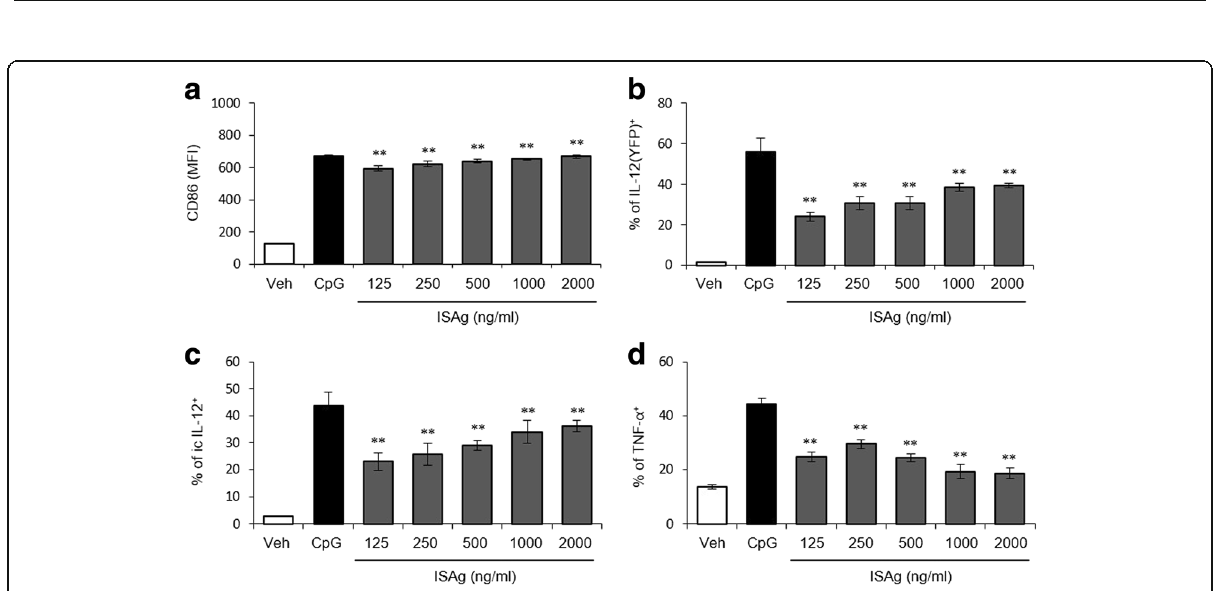
Fig. 4 ISAg enhanced production of Th1-type cytokines in BMDCs. Flt3L-cultured BMDCs from Yet40 B6 mice were stimulated for 16 h using a vehicle or the indicated concentration of ISAg. As a positive control, BMDCs were treated with CpG (5 μ g/mL). Subsequently, ( a ) the surface expression of CD86 and the production of ( b ) IL-12p40 (YFP), ( c ) intracellular IL-12p40, and ( d ) TNF- α were assessed in CD11c + BMDCs using flow cytometry. The mean ± standard deviation values are presented ( n = 3 per group; Student ’ s t-test; ** P <